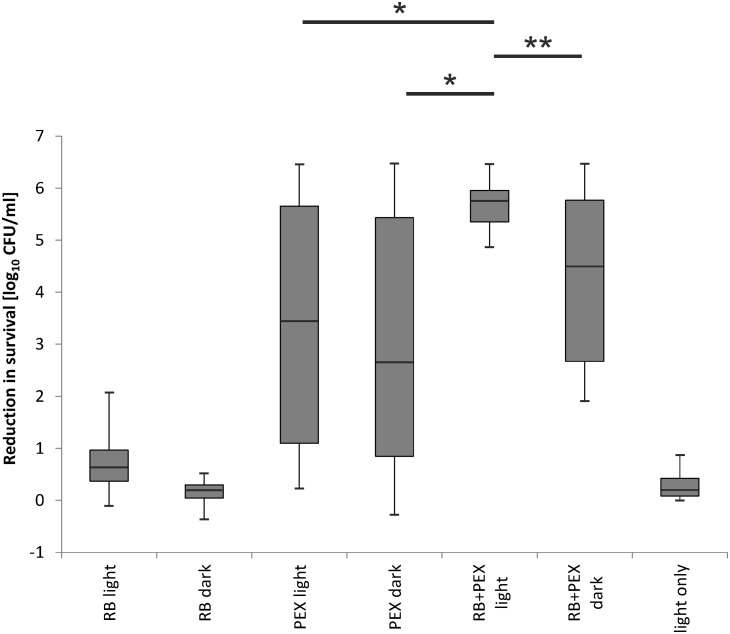
Evaluation of RB-based aPDI treatment combined with antimicrobial peptides against clinical isolates of P. aeruginosa. 36 isolates including a reference strain were analyzed with respect to overall aPDI plus PEX treatment. Efficacy of the treatment was assessed in the groups indicated on the abscissa. Each clinical isolate was incubated with RB and subjected to light (RB light) or kept in the dark (RB dark). The results of treatment with PEX upon light exposition (PEX light) and dark toxicity of PEX (PEX dark) are shown. Cells incubated with RB and PEX and irradiated (RB+PEX light), and the same combination kept in the dark (RB+PEX dark) are shown, respectively. Light only treatment is shown as control (light only). All strains were subjected to the same conditions of treatment, i.e., 5 μM of a compound studied, namely RB, PEX. In the case of combined treatment, the concentration of each compound was 5 μM. Irradiance applied was 23 mW/cm2, total fluence: 30 J/cm2. The error bars represent the minimum and the maximum value of log10 unit reduction in viable counts, horizontal lines represent medians. ANOVA with RIR Tukey post hoc test analysis was performed to indicate differences between RB+PEX light and the remaining studied groups. Significance at respective p-values are marked with asterisks (∗p = 0.0002, ∗∗p = 0.004).